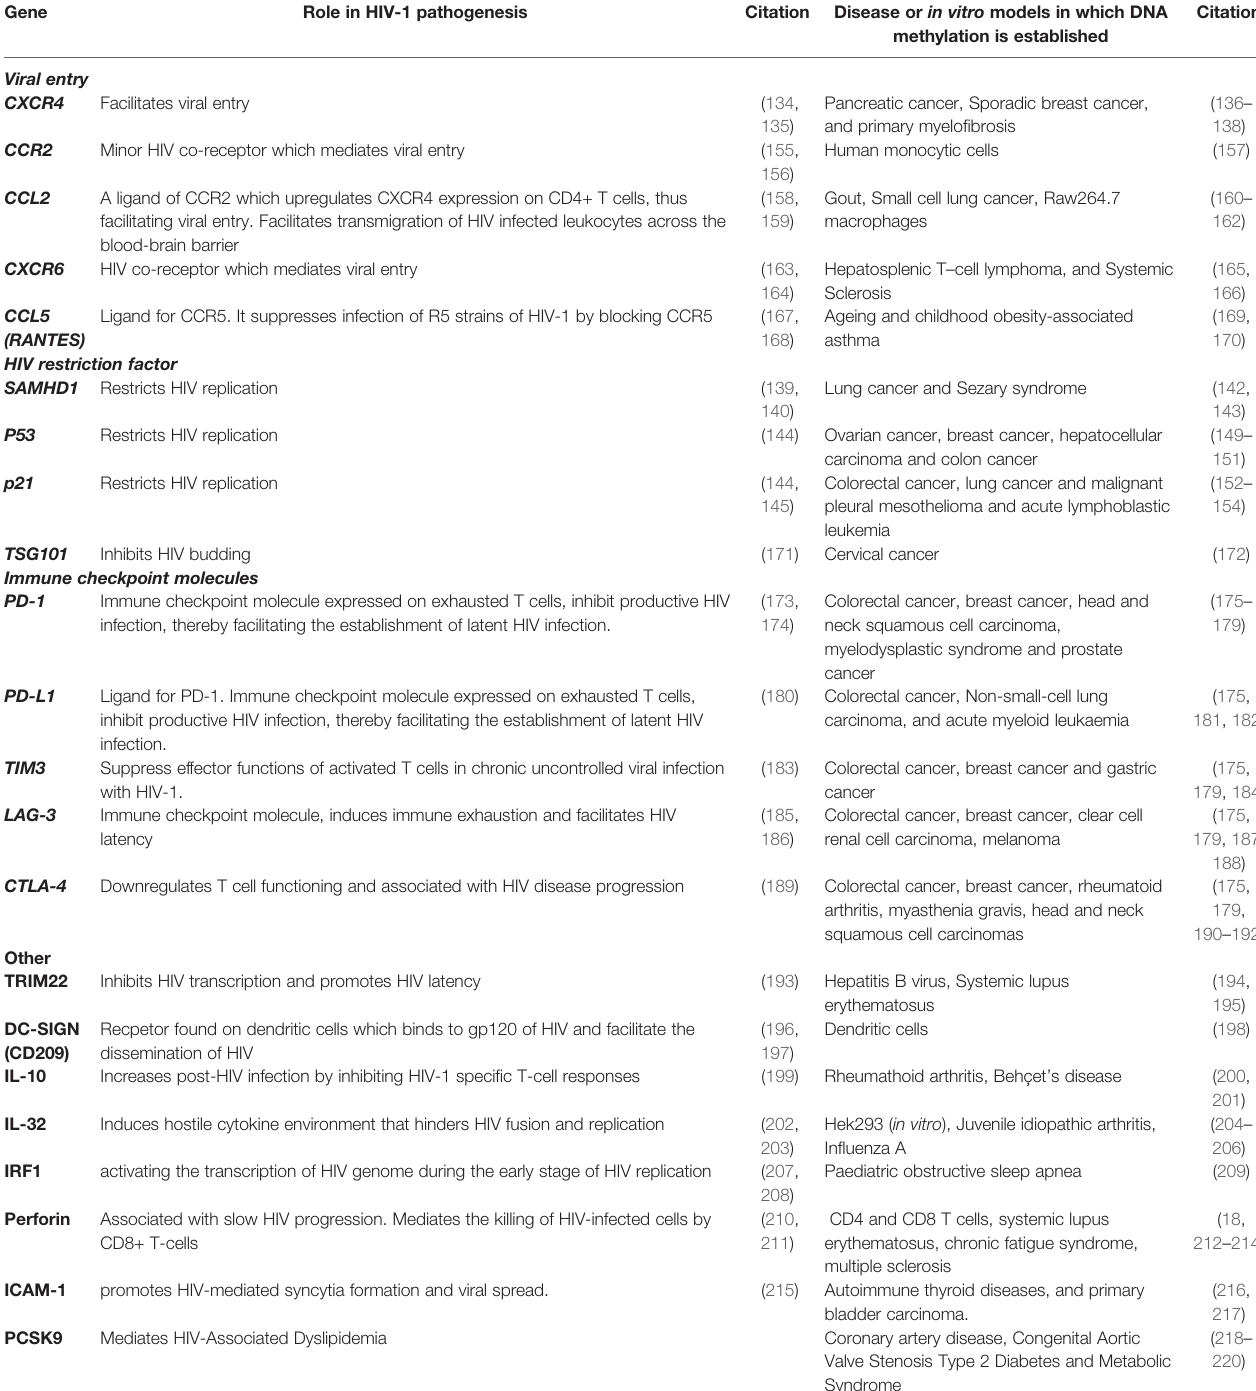
TABLE 1 | HIV-associated host genes that are regulated by methylation in other diseases or in vitro